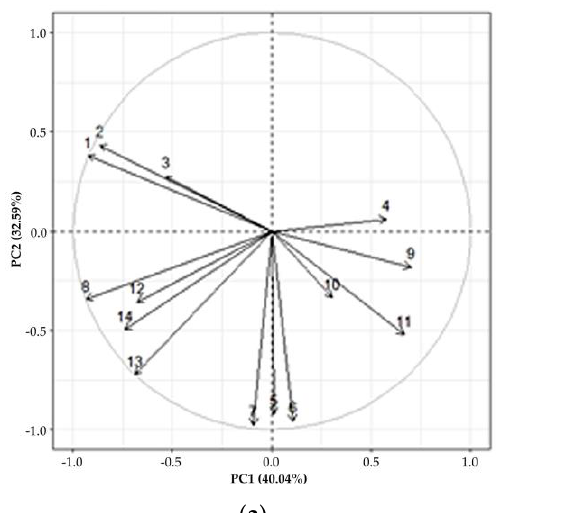
and combined stress of different intensities. ( a ) Salt stress; ( b ) Osmotic and combined stress. 1, Plant